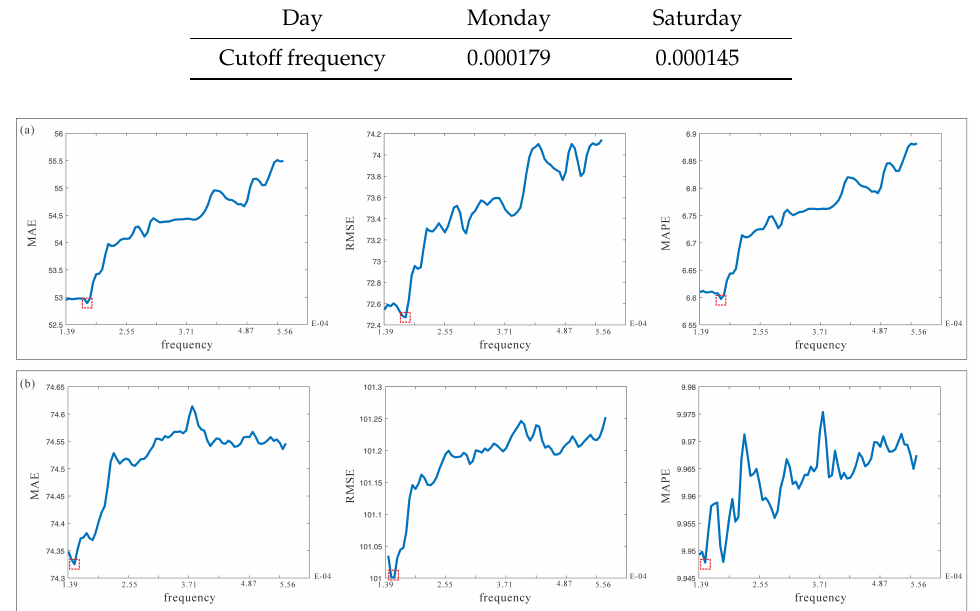
Table 2. Cuto ff frequencies obtained by the proposed A-CFS approach.